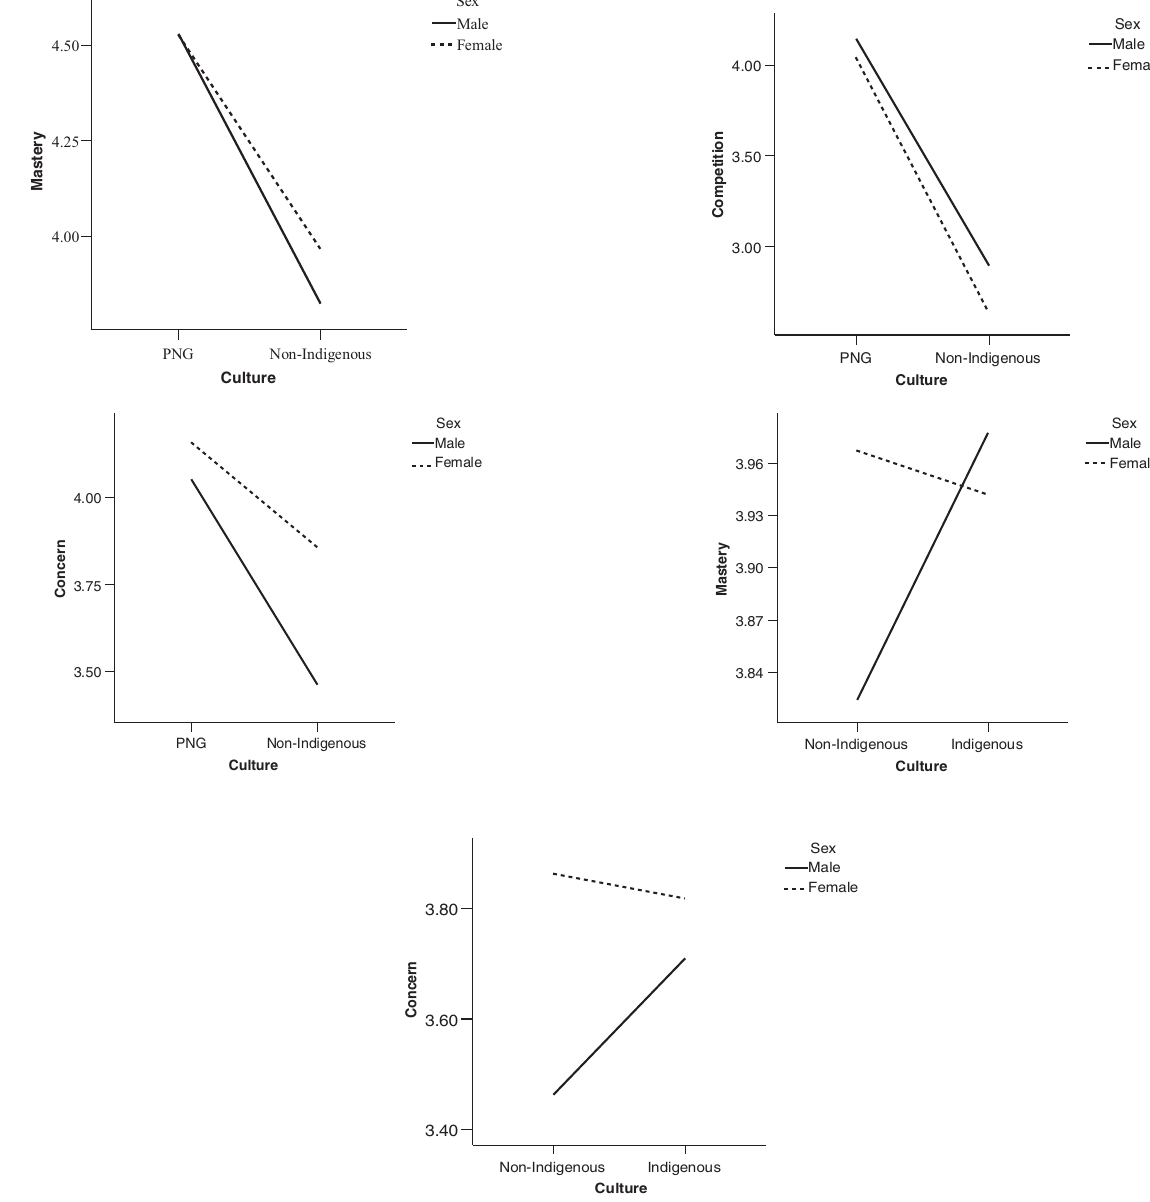
Visual representations of interaction effects. Note: Refer to Figure 2 for main effects and interaction path sizes.